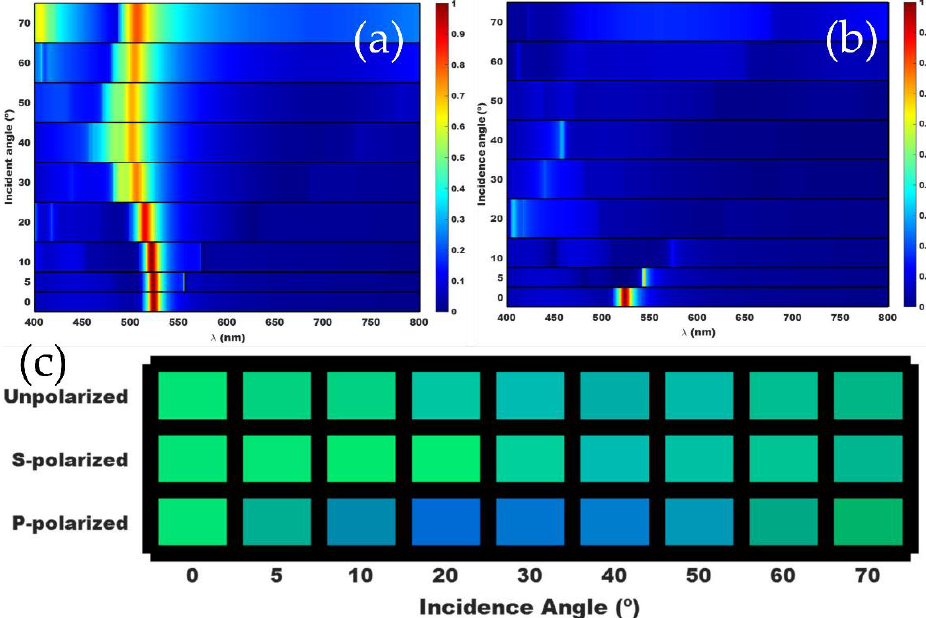
Figure 5. Reflectance spectra from a square array of period 350 nm consisting of TiO 2 disk resonators (on silica substrate) of radius 120 nm and of height 200 nm for the incident ( a ) s-polarized light and ( b ) p-polarized light. ( c ) Variation in the color palette for different incidence angles of unpolarized, s- and p-polarized light.